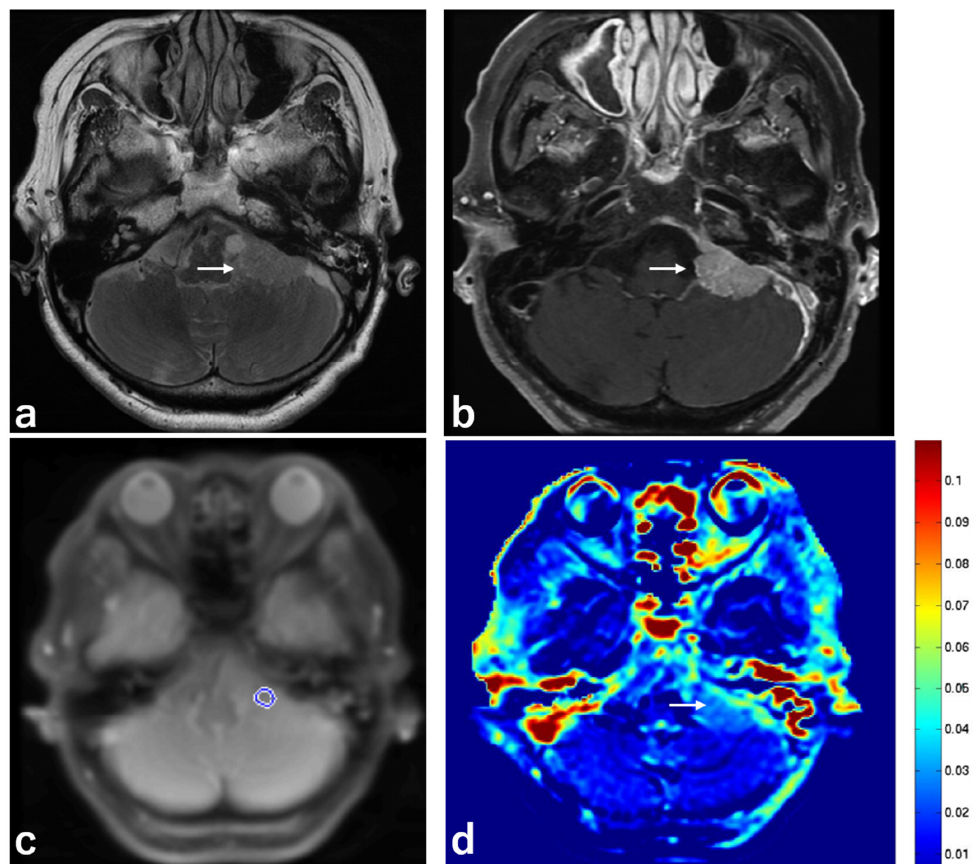
Figure 3. Imaging from a 78-year-old woman with a meningioma. ( a ) MRI, T2 sequence, axial section, showing homogeneous low intensity in a meningioma in the left CPA (white arrow). ( b ) MRI, 3D contrast-enhanced T1 sequence, axial section, showing homogeneous enhancement in a meningioma in the left CPA (white arrow). ( c ) MRI, APT-CEST scout image, axial section, showing the ROI (blue circle) in a meningioma in the left CPA. ( d ) MRI, APT-CEST sequence, axial section, showing low SI in a meningioma in the left CPA (white arrow).